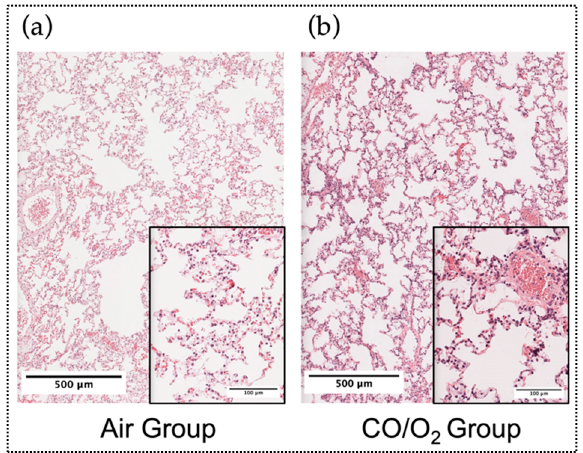
Figure 5. Light microscopic findings of the donor canine lungs after reperfusion by hematoxylin and eosin staining in the air ( a ) and CO/O 2 groups ( b ).